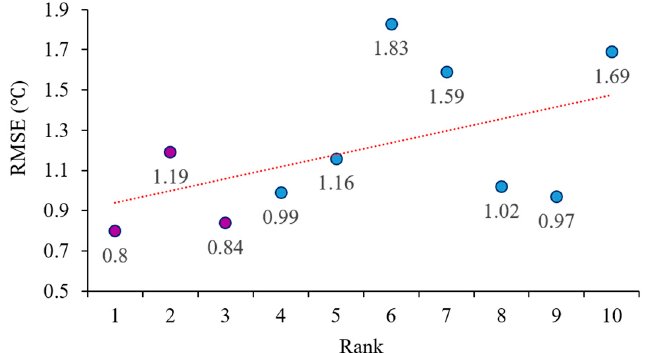
Figure 6. Rank according to Euclidean distance computed from prediction parameters (x axis). Root mean square error computations of analog days (forecast day: August 4, 2017, 06:00 UTC).